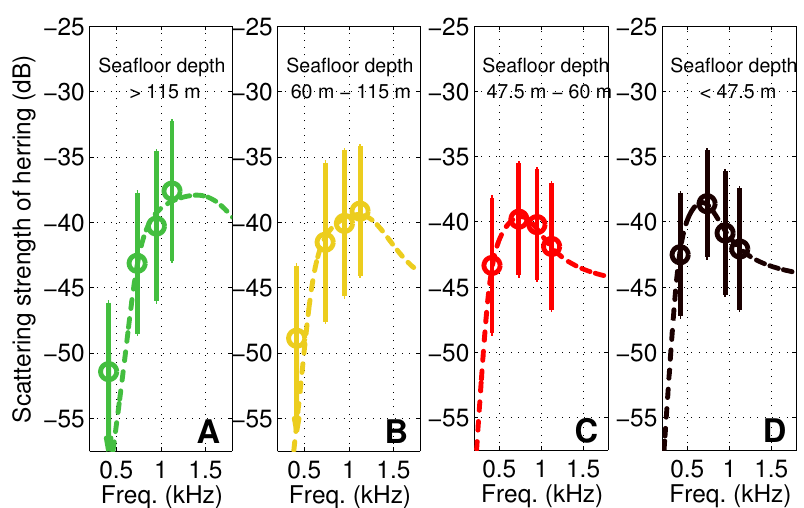
Figure 5. The resonance peak of herring scattering consistently shifts from frequencies higher than 1125 Hz to lower than 735 Hz with decreasing seafloor depths. ( A ) a typical frequency roll-off of roughly 20 dB/octave with decreasing frequencies from the resonance peak frequency at roughly 1500 Hz is found for spatial positions with seafloor depths deeper than 115 m; ( B – D ) the resonance peaks are found within the measured OAWRS frequency range from 1125 Hz to 415 Hz for the positions with shallower seafloor